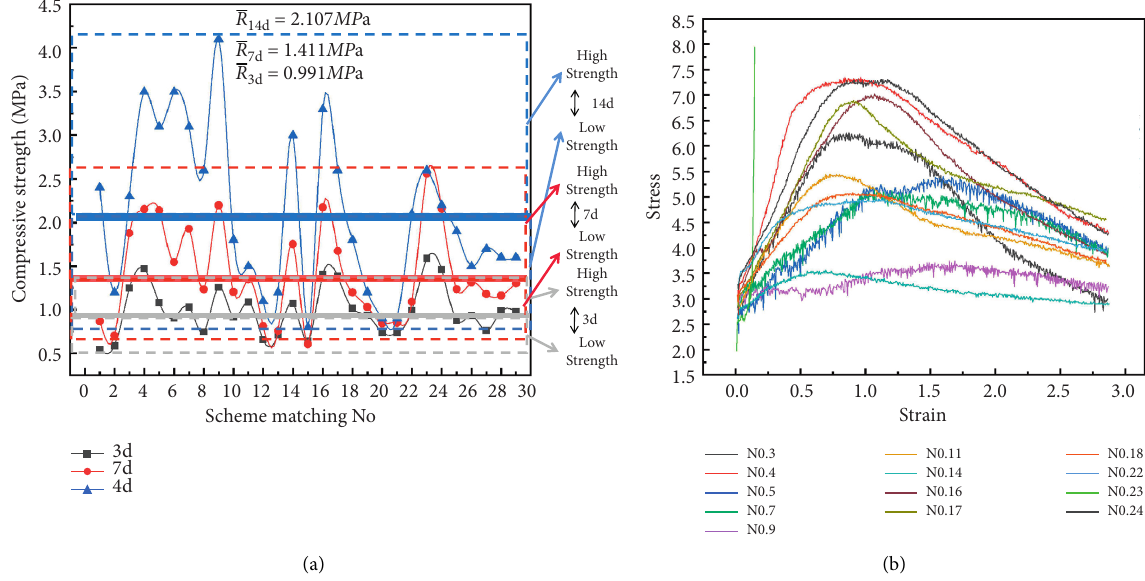
Figure 6: Change in compressive strength at different ages. (a) Compressive strength at different ages. (b) Stress-strain curve of the high- strength test block.